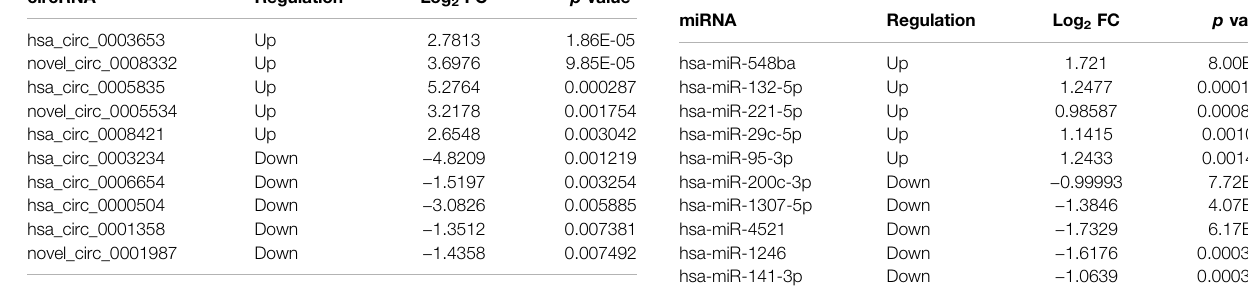
TABLE 3 | Top 10 differentially expressed microRNAs in decidua of URSA